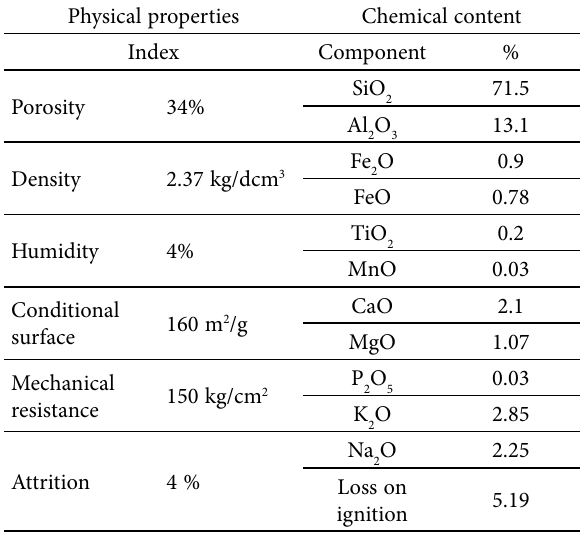
Table 1. The physico-chemical properties of natural zeolite used in this